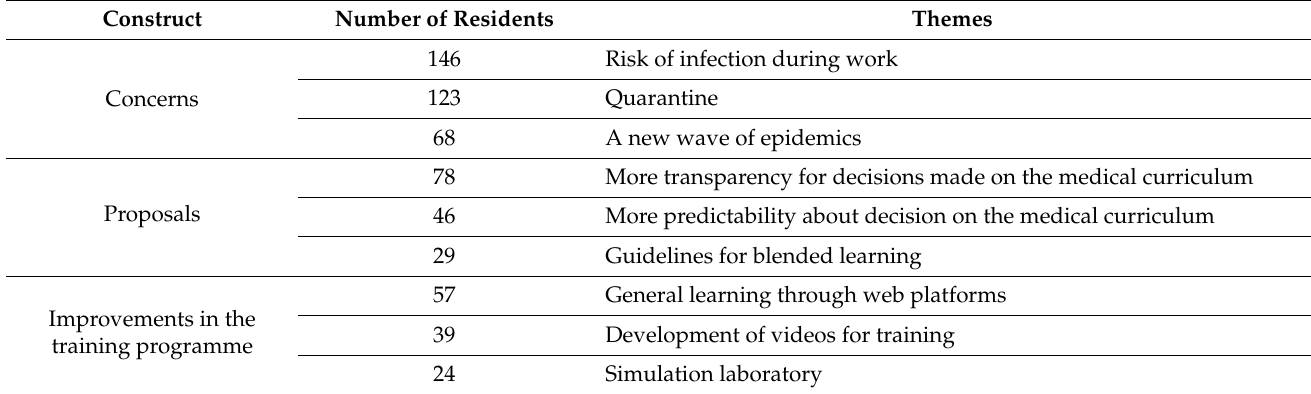
Table 5. Synthesis of qualitative findings by theme for the open-ended